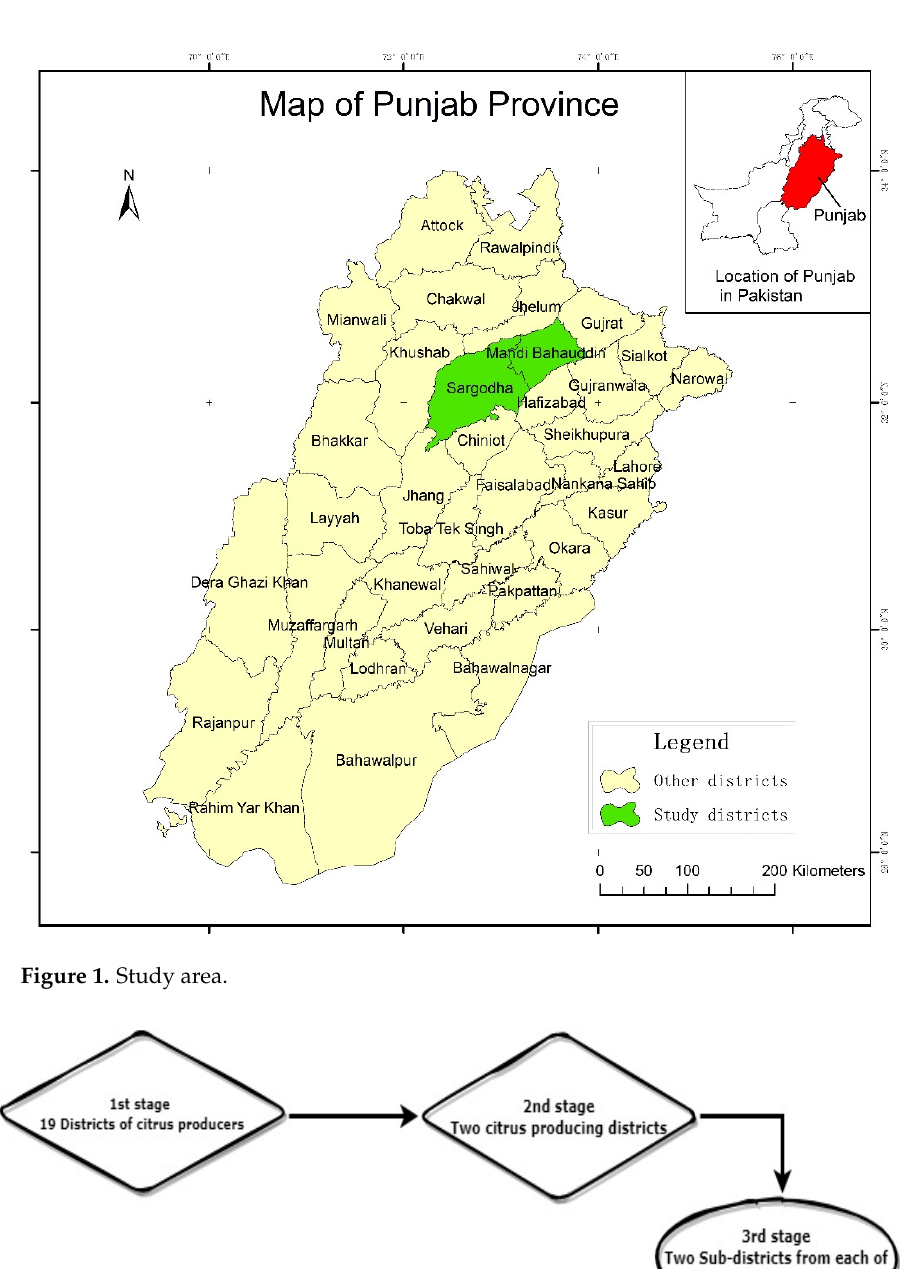
Figure 2. sampling framework. Figure 2. Sampling